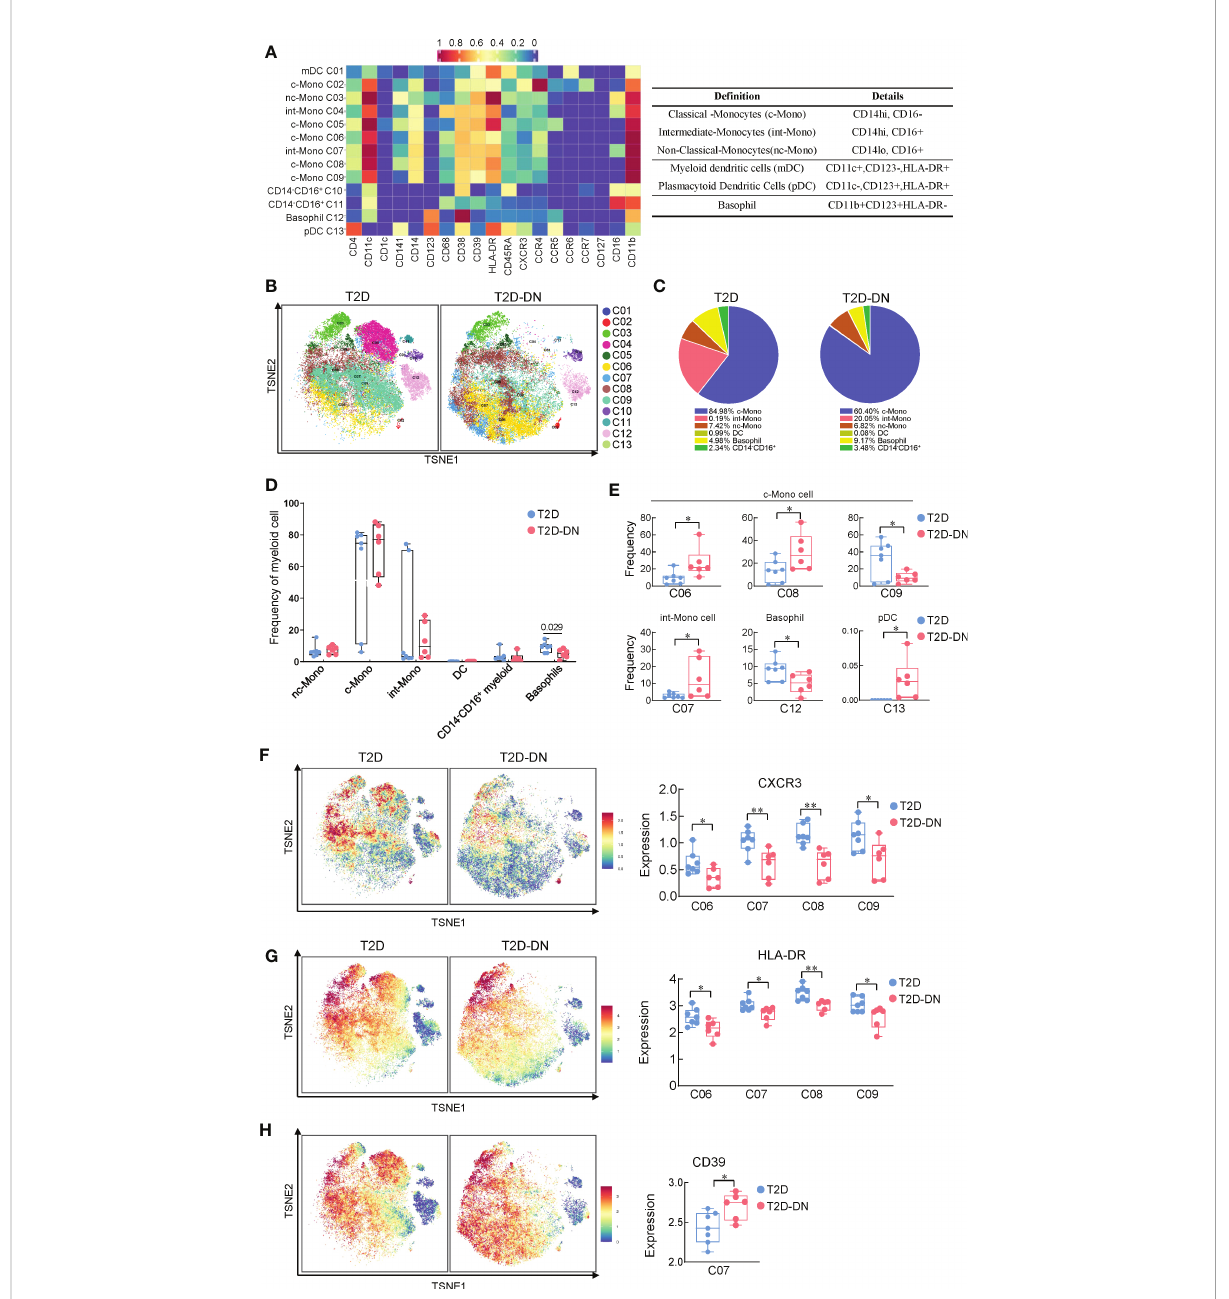
FIGURE 4 Immunological heterogeneity of myeloid cell subsets between T2D-DN and T2D patients. (A) Heatmap exhibiting the expressions of immune cell markers in the myeloid cell subsets (left) and six marked de fi nitions of myeloid cell subsets (right). (B) Island maps exhibit the measurable myeloid cell subsets distribution. (C) Pie chart characterizing the differences of signi fi cant myeloid cell subsets proportions between T2D-DN and T2D patients. (D) Statistical frequency differences of myeloid cell subsets between T2D-DN and T2D patients. (E) Signi fi cant changed myeloid cell subsets between T2D- DN and T2D patients. (F-H) The level of CXCR3 (F) , HLA-DR (G) , and CD39 (H) in the speci fi c myeloid cell subsets between T2D-DN and T2D patients. Data are expressed as means ± SEM, n = 6 in T2D-DN group and n = 7 in T2D group., * P < 0.05, ** P < 0.01 vs. T2D